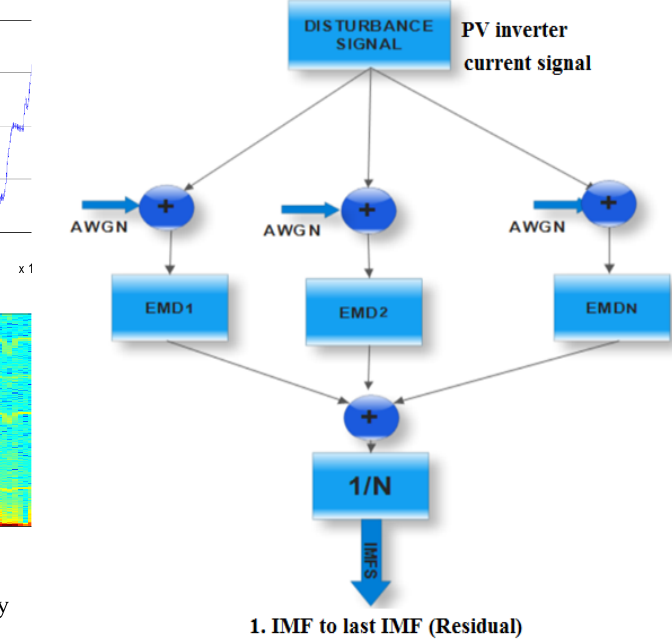
Fig. 3. The representation of the EEMD algorithm[16]